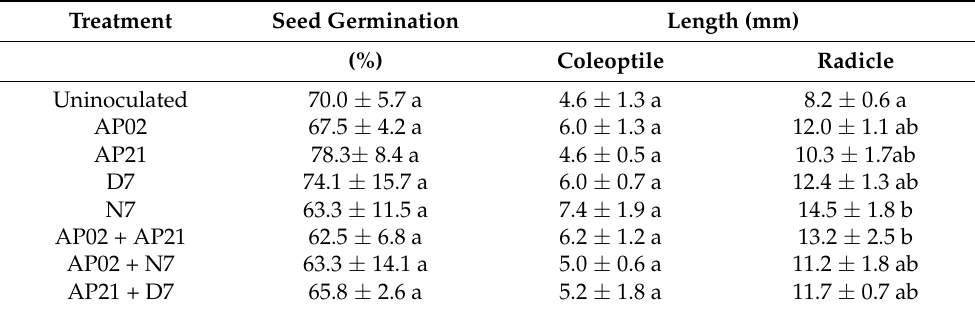
Data are presented as mean ± standard deviations. Means and standard deviations are the results of four replicates. Different letters represent statistically different groups according to the Kruskal–Wallis and pairwise comparison ( p <